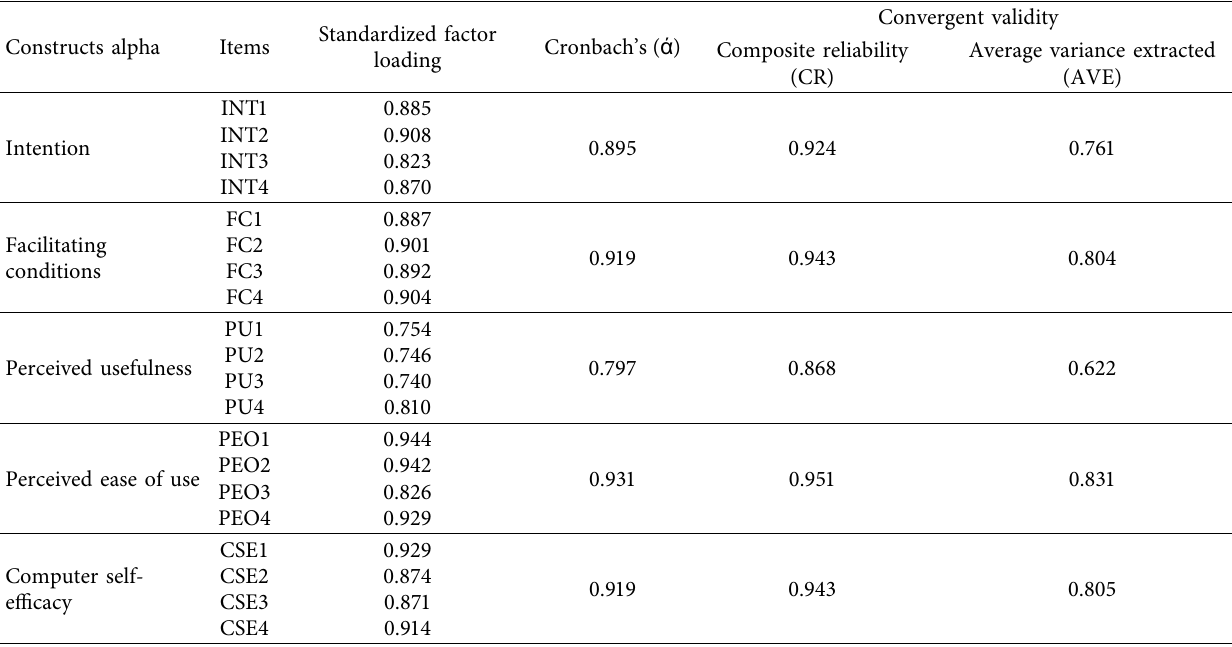
Table 3: Measurement